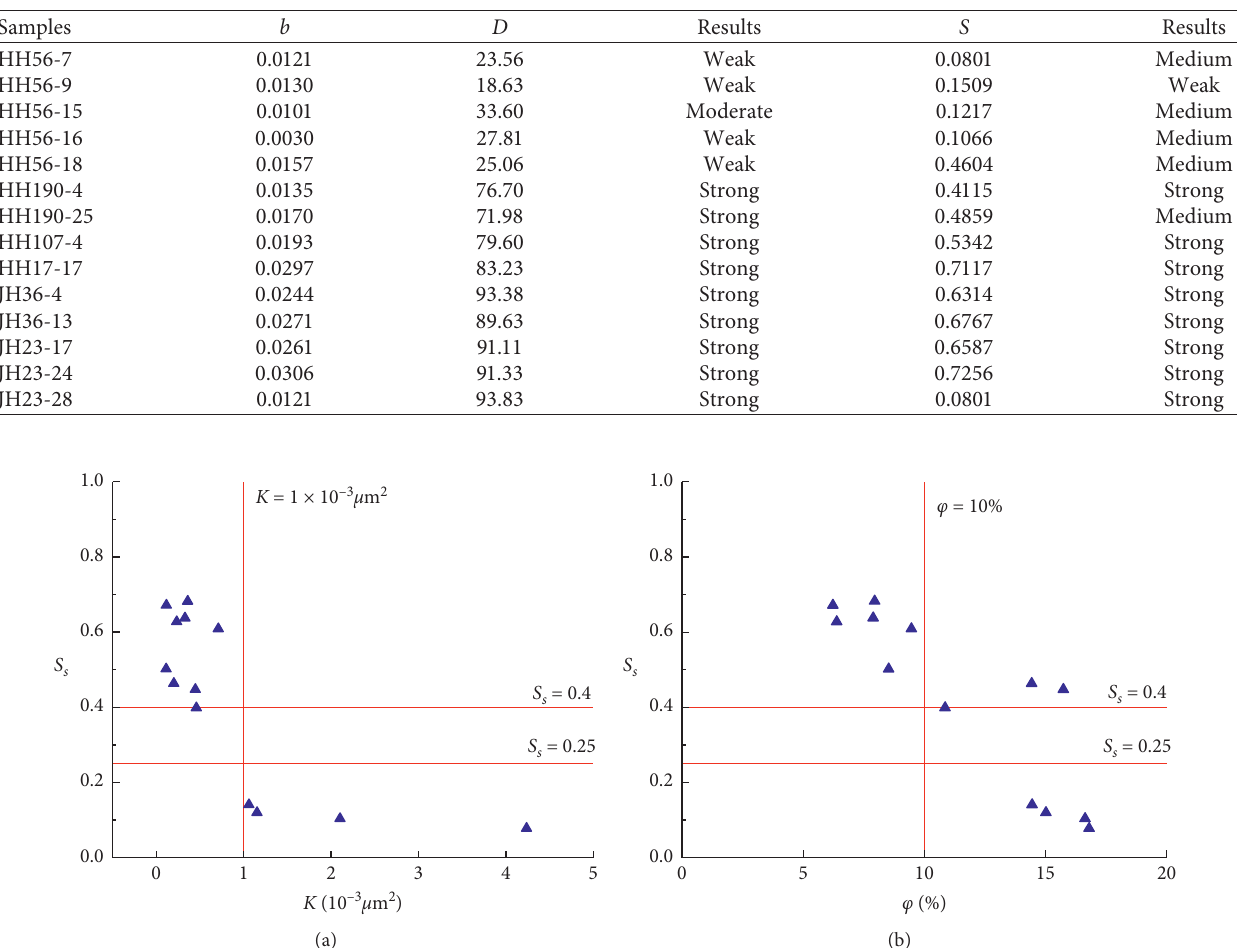
Table 2: Core stress sensitivity evaluation results.